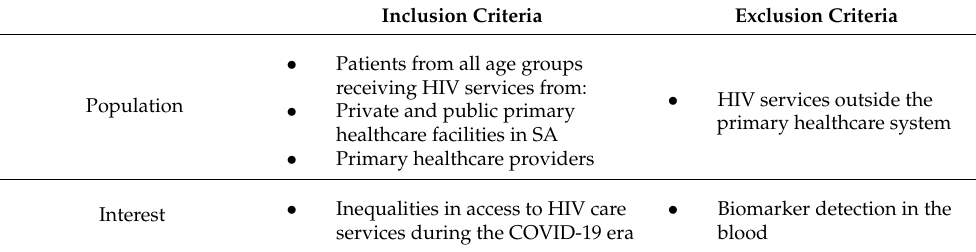
Table 1. Inclusion and exclusion